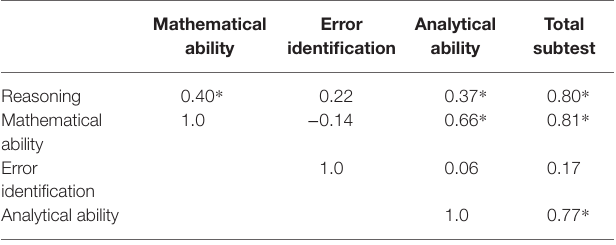
TABLE 3 | Correlation coefficients between scores on different parts of the cognitive ability subtest, and between parts and total subtest score. Mathematical ability